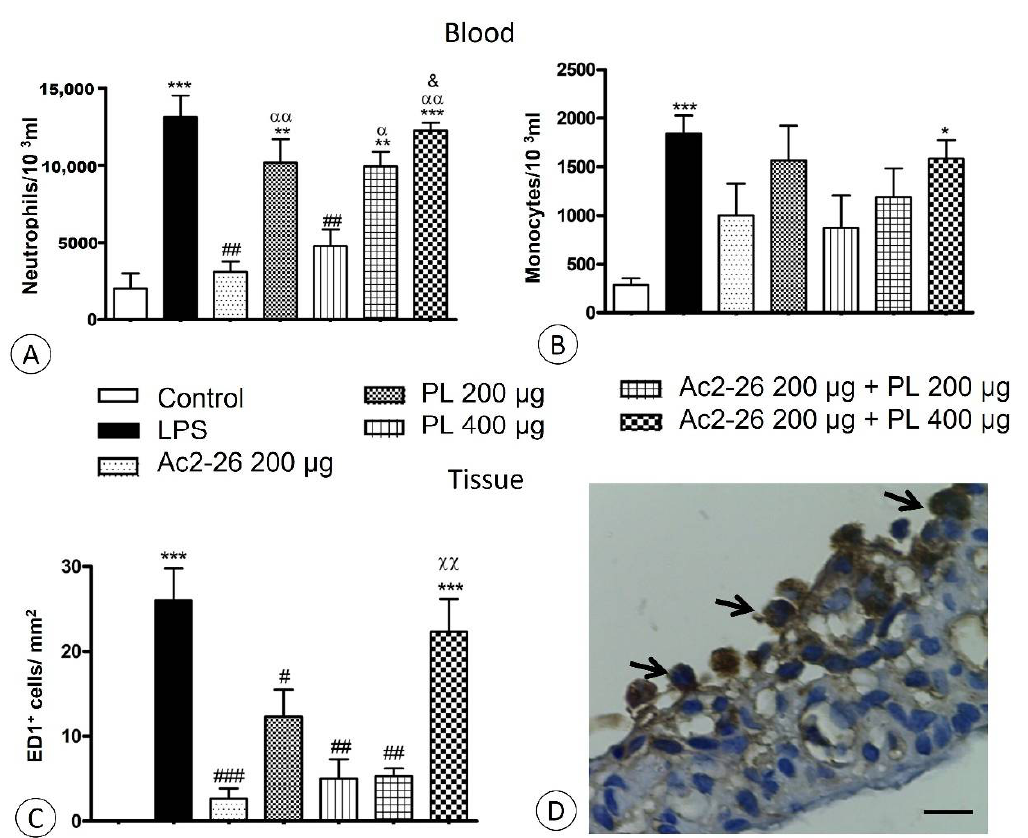
Figure 3. Quantitative analyses of neutrophils ( A ) and monocytes ( B ) in blood . Data show mean ± SEM of neutrophils and monocytes × 10 3 mL in the blood of control, untreated (LPS), and treated (Ac2-26 200 µg, PL 200 µg, PL 400 µg, Ac2-26 + PL 200 µg, and Ac2-26 + PL 400 µg) rats ( n = 10 animals/group). *** p < 0.001, ** p < 0.01, and * p < 0.05 versus control; ## p < 0.01 versus LPS; αα p < 0.01 and α p < 0.05 versus Ac2-26 200 µg; and & p < 0.05 versus PL 400 µg. Quantification of phagocytic mononuclear cells in the anterior segment of the eye ( C ). Data show mean ± SEM of ED-1 positive cells per mm 2 in the eyes of control, untreated (LPS) and treated (Ac2-26 200 µg, PL 200 µg, PL 400 µg, Ac2-26 + PL 200 µg and Ac2-26 + PL 400 µg) rats. ( n = 10 animals/group). *** p < 0.001 versus control; # p < 0.05, ## p < 0.01, and ### p < 0.001 versus LPS; and χχ p < 0.01 versus Ac2-26 200 µg, PL 400 µg, and Ac2-26 200 µg + PL 200 µg. ED-1 positive cells (arrows) on iris induced to uveitis and untreated ( D ). Sections: 5 µm, counterstain: hematoxylin, bars: 10 µm.